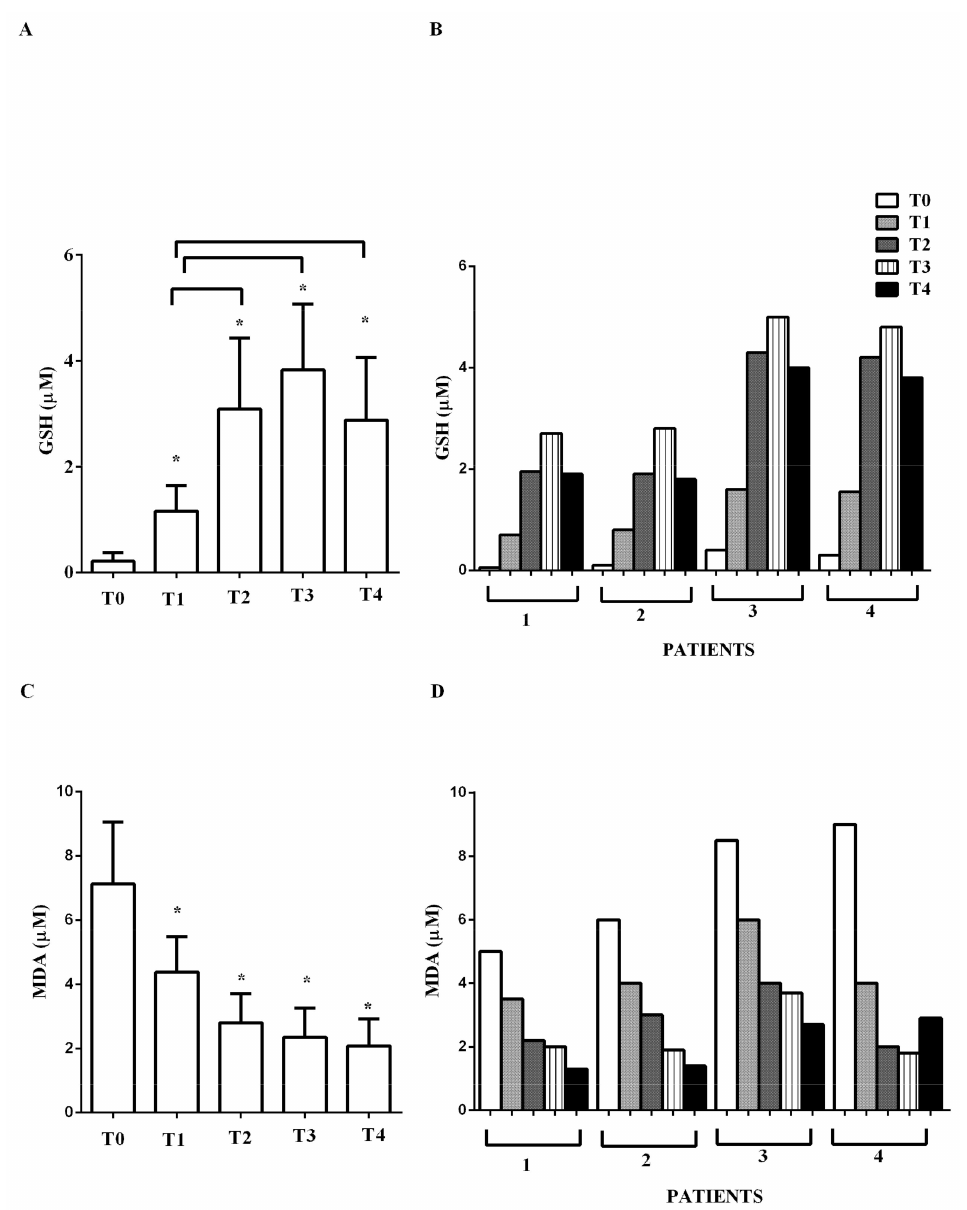
Figure 7. In ( A , B ), e ff ects of levosimendan on plasma glutathione (GSH) and in ( C , D ), on plasma malonyldialdeide (MDA) concentration. In A and C, values are means ± SD. In B and D, columns represent single patients. * p < 0.05 vs.